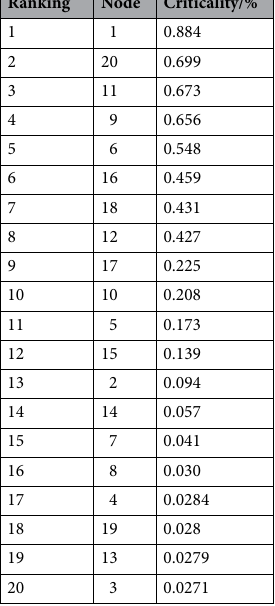
Strategies SAC strategies